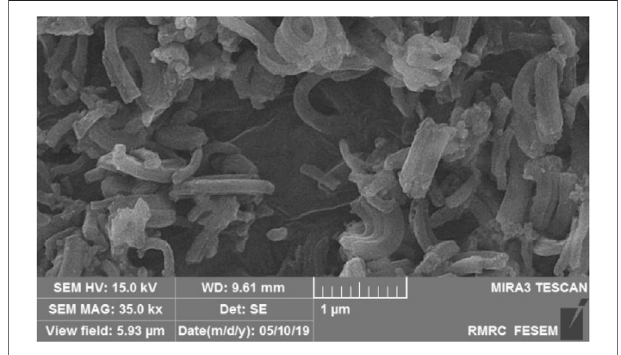
FIGURE 4 | SEM image of the recovered Pd@Py 2 PZ@MSN catalyst.